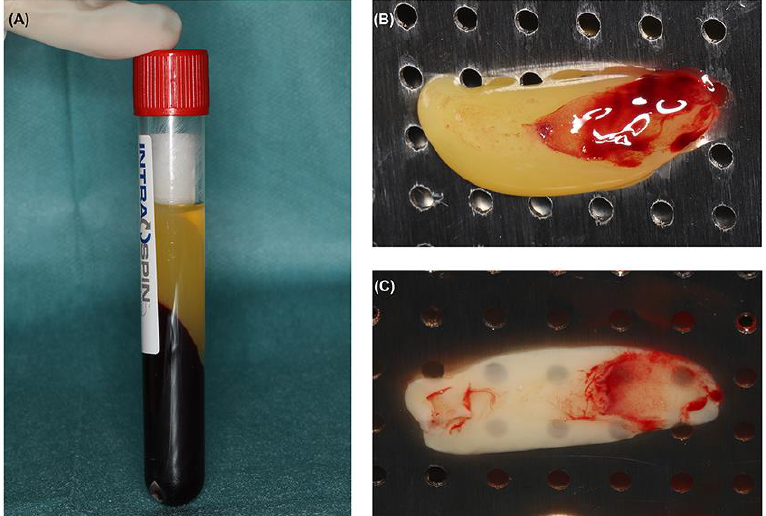
Figure 1. L-PRF preparation. ( A ) Tubes after centrifugation process. Content in three layers: red blood cells, L-PRF clot, and acellular plasma—from the lower end to the top of the tube; ( B ) L-PRF clot; ( C ) L-PRF membrane.